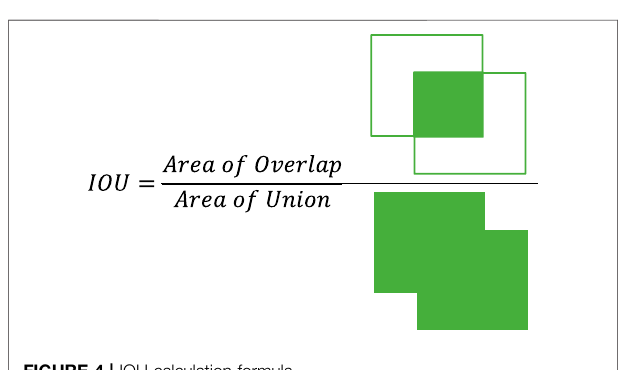
FIGURE 4 | IOU calculation